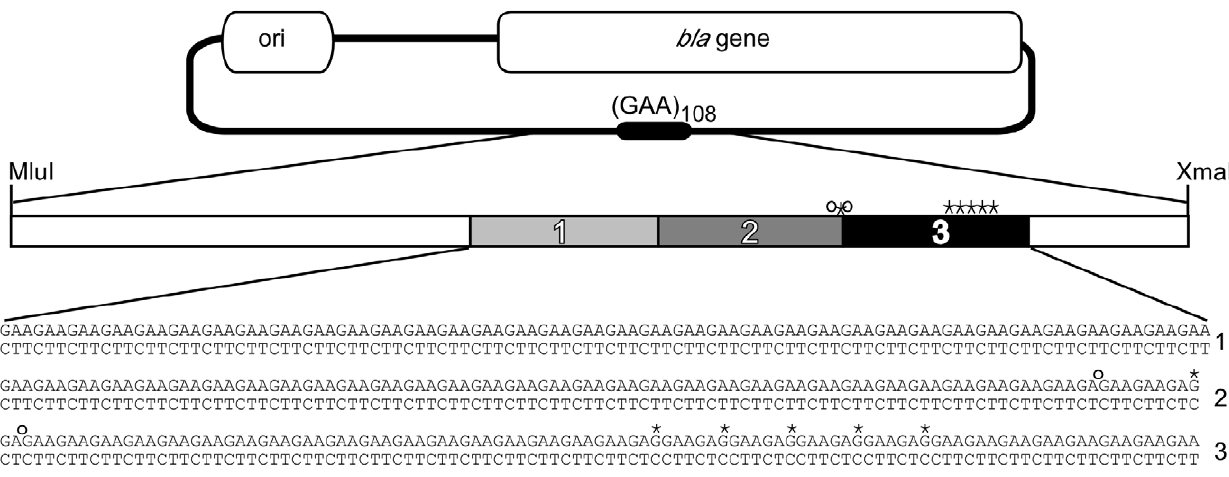
Figure 1. Experimental Target . Plasmid targets for in vitro transposition reactions contained 108 GAA N TTC repeats. Hollow boxes indicate essential regions (ori, bla ) of the plasmid excluded from recoverable transposition events. The expected frequency of insertion into the (GAA N TTC) 108 region based on its contribution to the size of the plasmid (minus the essential regions) is 9%. The repeat is located between restriction sites MluI and XmaI. The repeat is divided into thirds, and point deletions and substitutions in the GAA repeat are indicated by open circles and asterisks, respectively. The sequence of this repeat, divided into thirds, is shown at the bottom of the figure. The complete sequence of the insert is available online (GU722204).